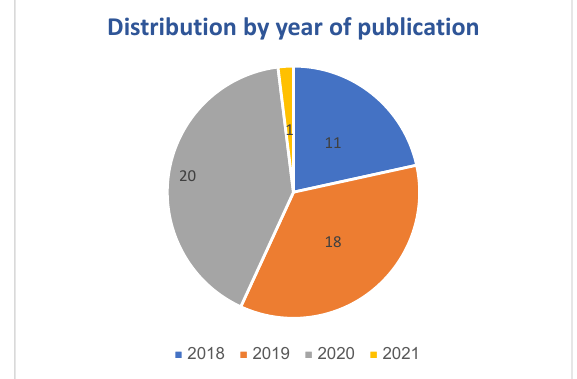
Figure 6. Distribution by year of publication.